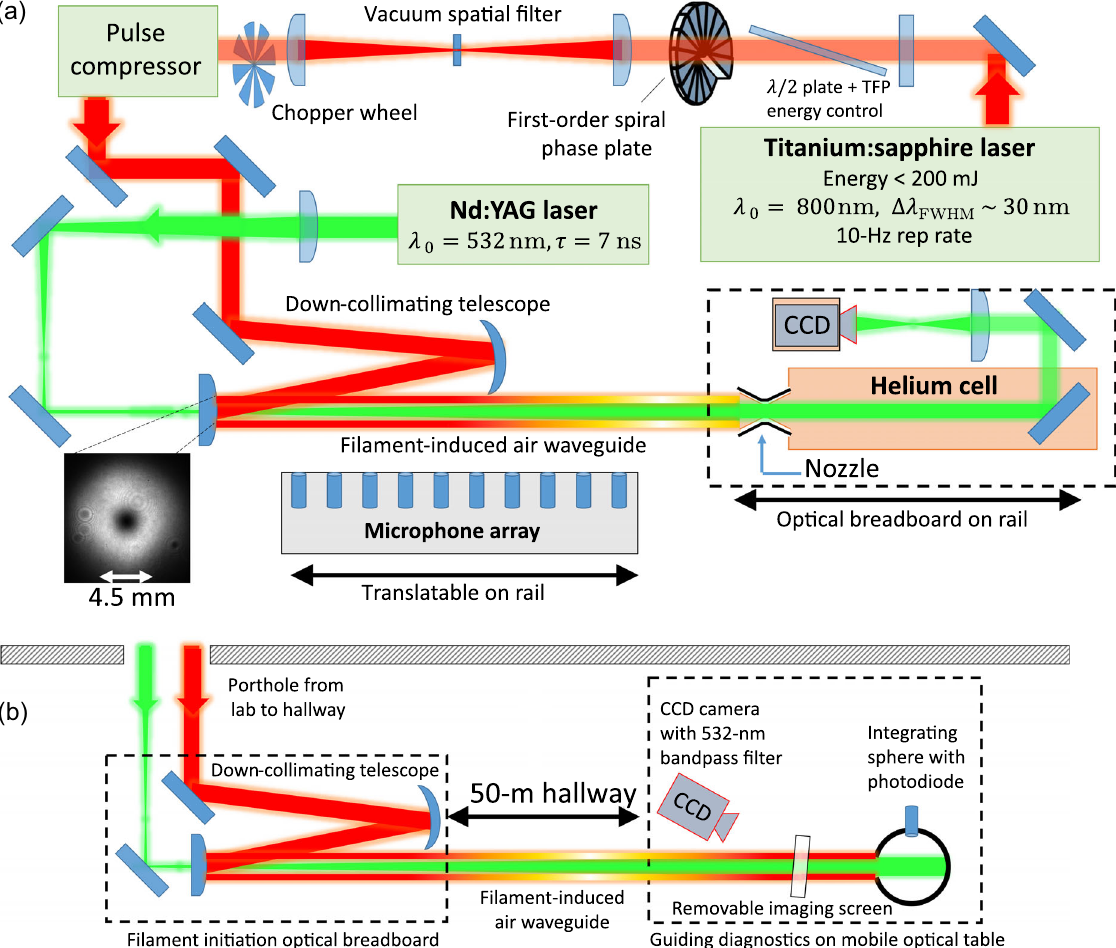
FIG. 2. (a) Experimental setup for 8-m in-lab guiding experiments. (b) Setup for 50-m hallway guiding experiments. The alumina ceramic imaging screen was used for guided-mode measurements for the λ ¼ 532 nm, 7-ns, 1-mJ probe pulse (Fig. 8). The integrating sphere was used in guiding lifetime measurements using a CW λ ¼ 532 -nm probe beam (Fig. 10). The CCD camera and integrating sphere use 532-nm interference